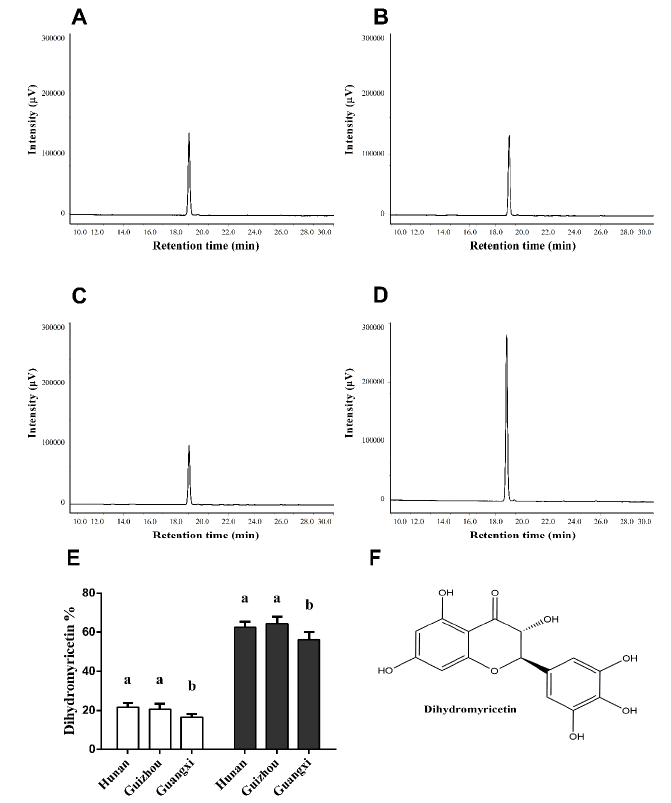
Figure 3. Dihydromyricetin determination in vine tea polyphenols by high-performance liquid chromatography (HPLC). The HPLC profiles of vine tea polyphenols (VTP) from Hunan Province ( A ), Guizhou Province ( B ), Guangxi Province ( C ) as well as the VTP plus standard dihydromyricetin